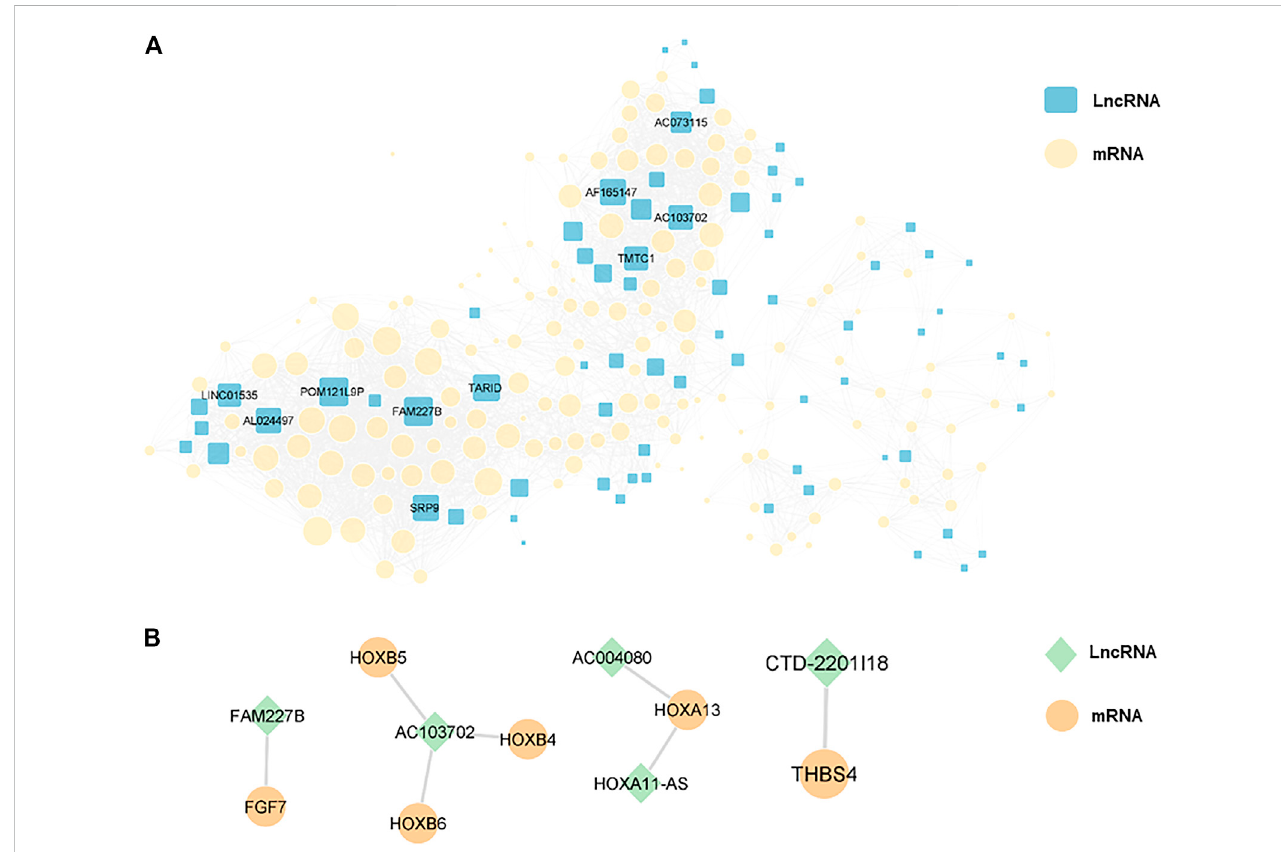
FIGURE 7 (A) ,alncRNA-mRNAco-expressionnetworkwith226nodesand3,390edgeswasconstructed,andthetop10lncRNAsrankedbyconnectivitydegreein the network were highlighted as squares. The larger the square, the higher connectivity degree. Blue squares represented lncRNAs and yellow circles represented mRNAs. (B) , cis-regulation predictive analysis on the differentially expressed lncRNAs and mRNAs was performed. The top fi ve lncRNAs with signi fi cant differences were listed separately, with green diamonds represented lncRNAs and yellow circles represented mRNAs.